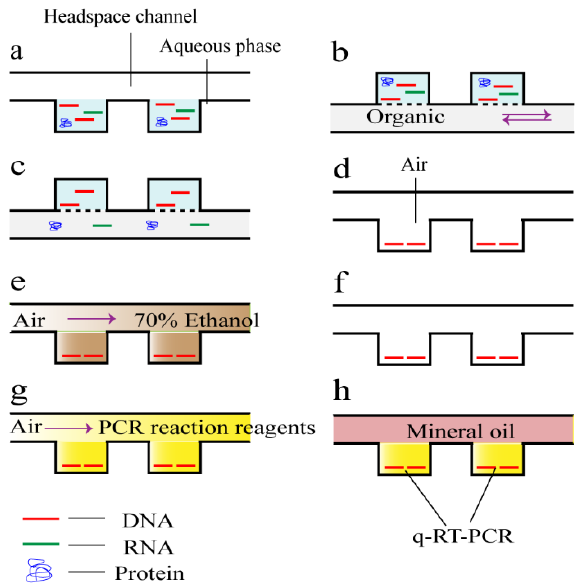
Figure 3. Schematic of the DNA purification process in a liquid-phase DNA isolation chip described by Zhang et al. [51]. ( a ) An aqueous phase containing DNA, RNA, and protein was loaded in the microwells. ( b ) An organic phase with pH 8.0 was introduced into the headspace channel with continuous forward and reverse flow. The chip was inverted for nucleic acid purification in this step as the organic phase has greater density than the aqueous phase. ( c ) Protein and RNA were transferred from the aqueous phase into the organic phase, while DNA remained in the aqueous phase. ( d ) The organic phase was expelled from the headspace channel and evaporated under vacuum while purified DNA in the microwell was concurrently dried ( e , f ). Residual organic phase was further decontaminated by repetitive washing and vacuum evaporating with 70% ethanol. ( g ) q-RT-PCR reaction mixture was loaded into the microwells. ( h ) Microwells were covered with mineral oil followed by on-chip q-RT-PCR amplification.